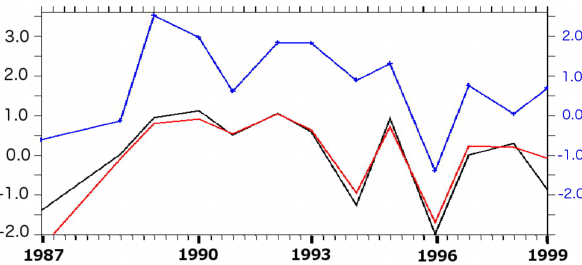
Fig. 19. Leading principle components of observed (red line) and simulated (black line) sea- Figure 19. Leading principal components of observed (red line) and sonal mean ice concentrations. The blue line (and right y axis) depicts the (unitless) NAO-index simulated (black line) seasonal mean ice concentrations. The blue for comparison. line (and right y axis) depicts the (unitless) NAO index for compar-